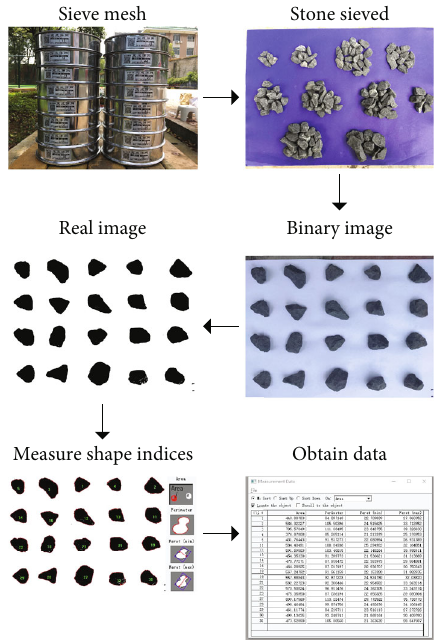
Figure 4: The experiment procedure to obtain the data of shape